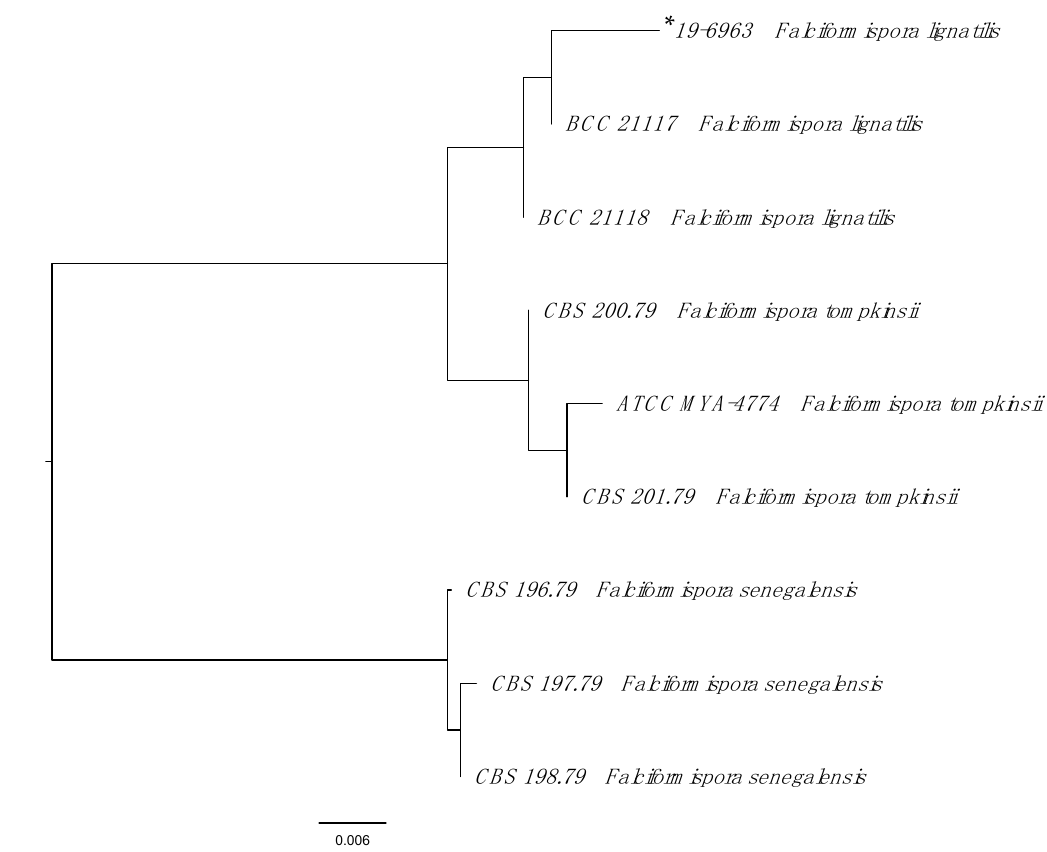
Figure 2. Phylogenetic tree of Falciformispora species reported to cause eumycetoma. The Neighbour-joining tree was constructed from combined partial 28 S and internal transcribed spacer sequences. See Ahmed et al. [6] for a more comprehensive phylogenetic overview of all agents of eumycetoma. * Indicates clinical strain.